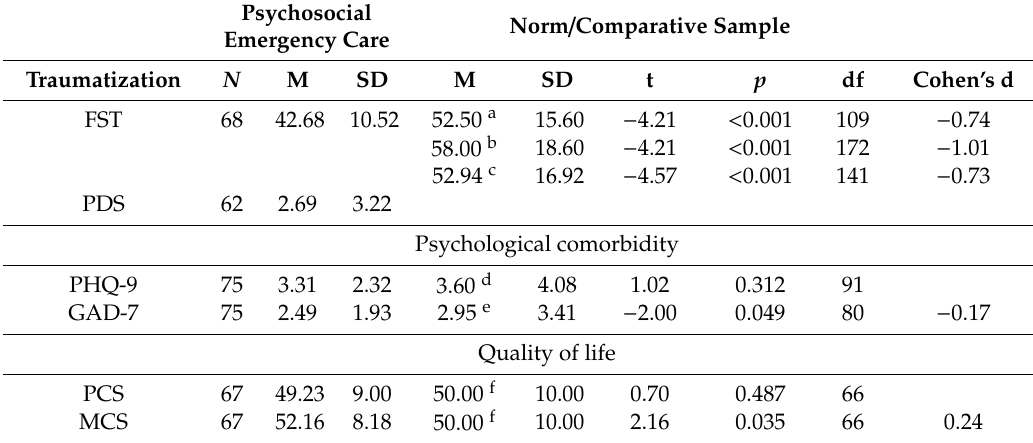
Table 2. Traumatization and psychological burden of volunteers in psychosocial emergency care.